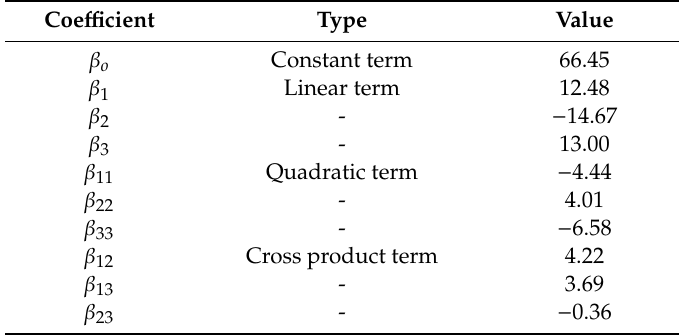
Table1. Regressioncoe ffi